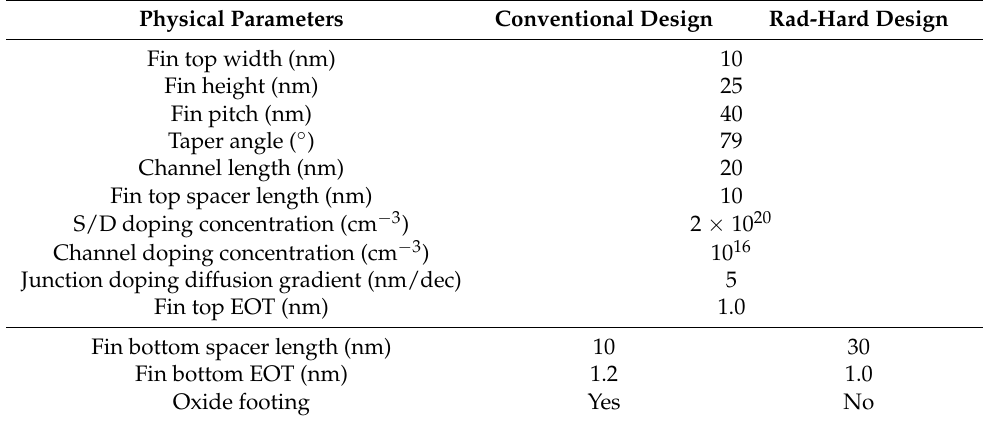
Figure 3. The 14 nm node FinFET process results for physical parameter extraction. ( a ) The 3D S/D’s TEM and ( b ) the fin geometry fabricated by IMECAS [25]. The extracted physical parameters are listed in Table 2. Table 2. Physical parameters used in 14 nm node SOI FinFET